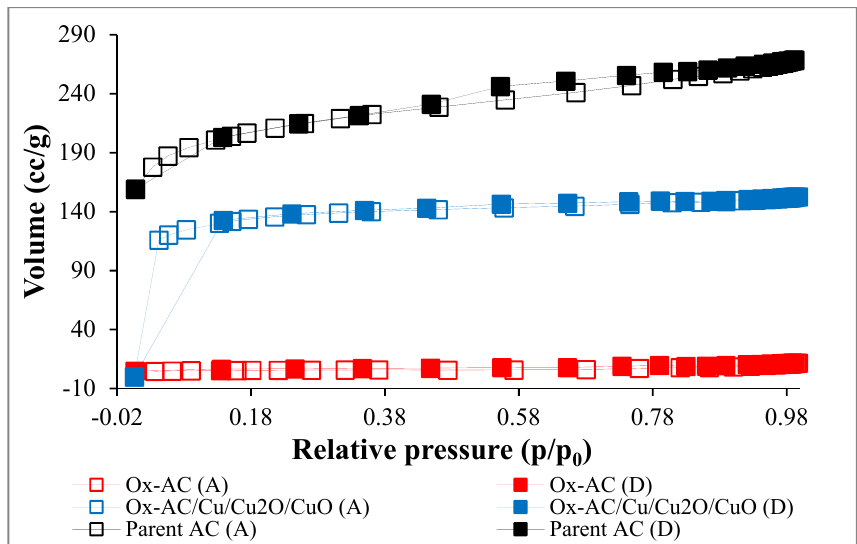
Figure 3. N 2 adsorption (unfilled points described by letter (A))-desorption (filled points described by letter (D)) isotherms at 77 K for parent AC, Ox-AC, and Ox-AC/Cu/Cu 2 O/CuO.